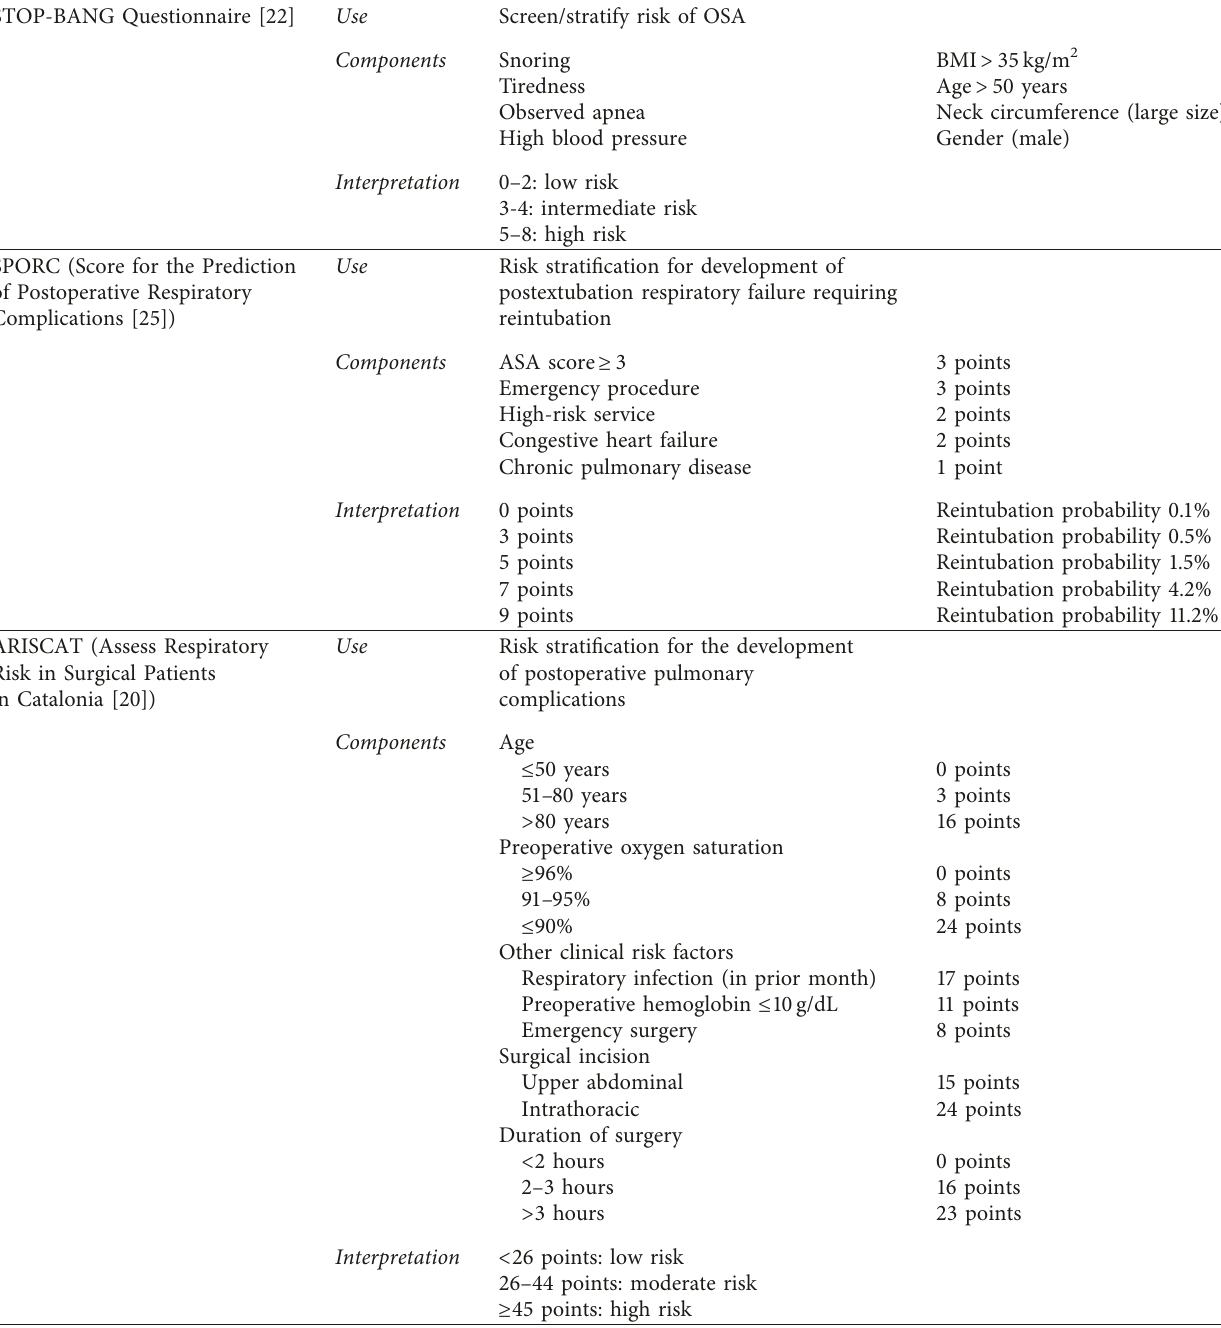
Table 1: Respiratory risk stratification scoring systems [20, 22,